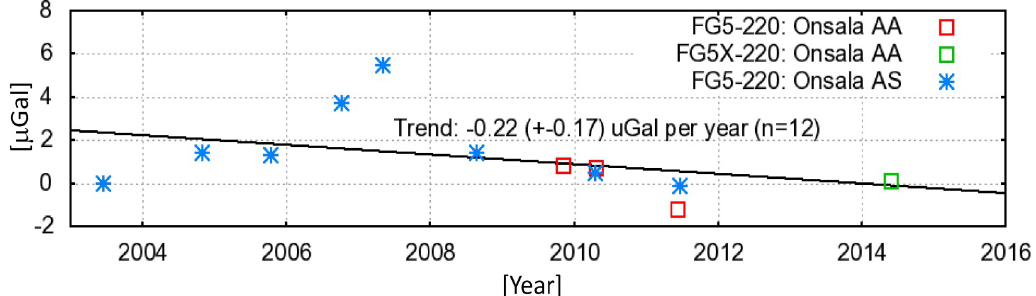
Figure 2: Gravity variations at Onsala as obtained with the gravimeter FG5(X)-220 of LUH (since 2003) in combination with the supercon- ducting gravimeter GWR#54 (since 2009).